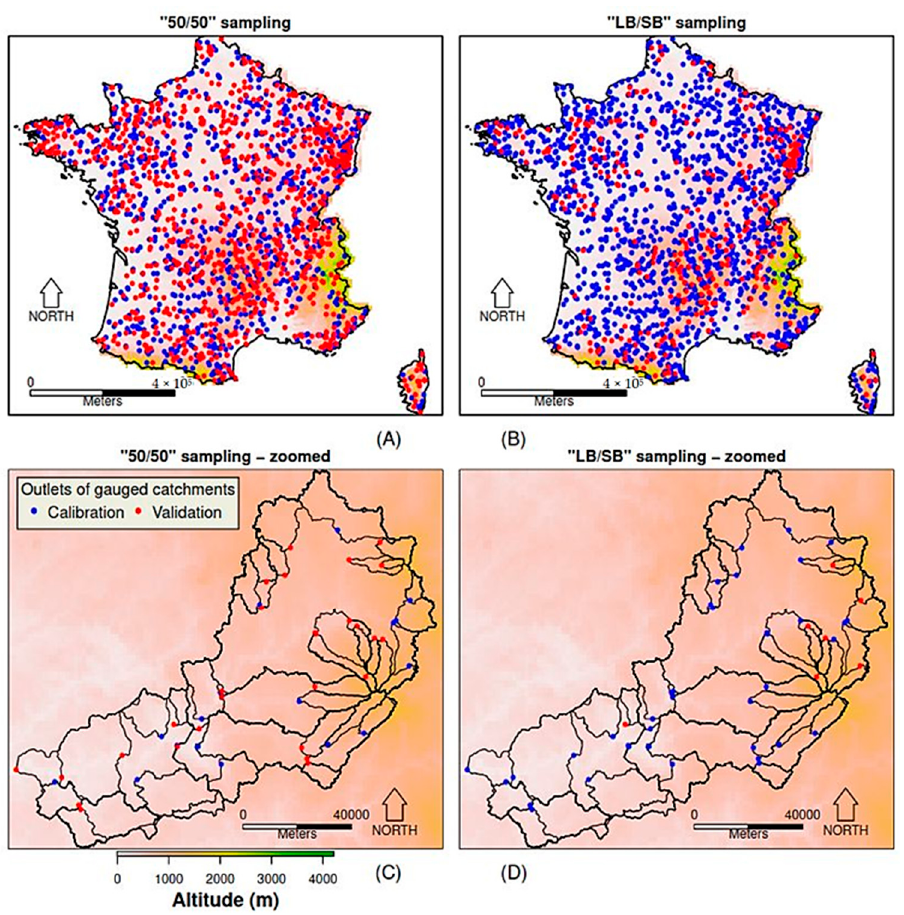
Figure 3. Location of catchments for “50/50” sampling ( A ) and “LB/SB” sampling ( B ) with a zoomed example ( C , D